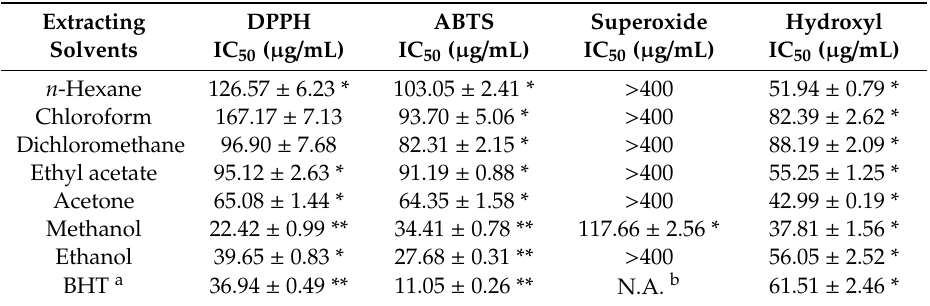
Table 2. The antioxidant activities of di ff erent solvent extracts from Myristica fragrans determined with 2,2-diphenyl-1-(2,4,6-trinitrophenyl)hydrazyl (DPPH), 2,2 (cid:48) -azino-bis(3-ethylbenzothiazoline-6-sulfonic acid) (ABTS), superoxide, and hydroxyl